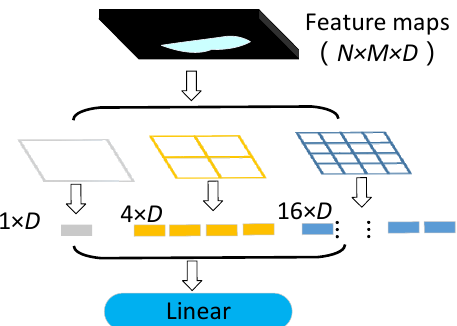
Figure 6. Schematic diagram of spatial pyramid pooling strategy. The improved ResNet convolution network simply called AM-SPPResNet. Figure 7 shows the network structure used in this paper.